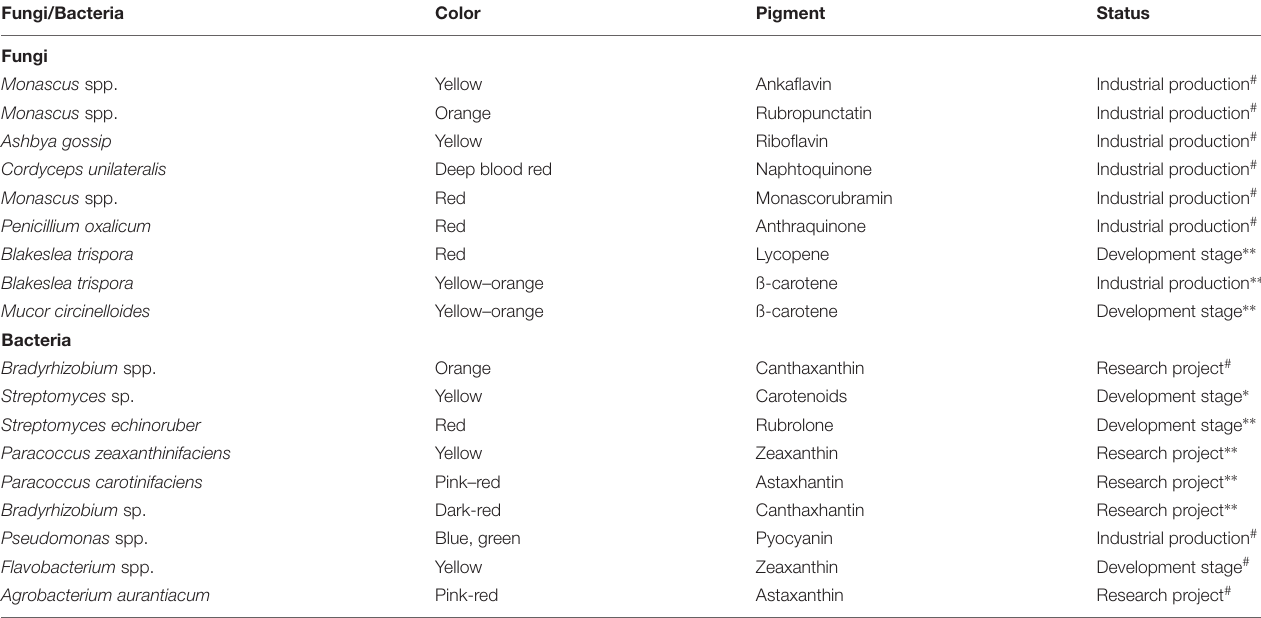
TABLE 2 | Fungal and bacterial pigments studied or applied for commercial